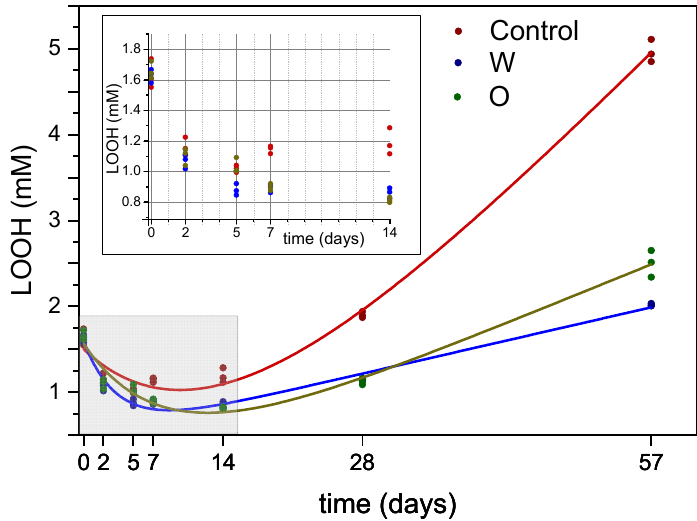
Figure 2. Trend of hydroperoxides in O/W emulsions, added with OPA, during accelerated oxidation test with AAPH radical initiator. Control, control emulsion; O, emulsion with OPA added to the oil phase; W, emulsion with OPA added to the water phase. Shah fitting is reported (see text for details on the model).